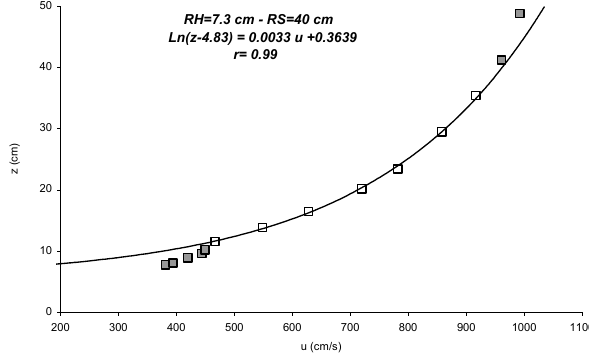
Fig. 2. Measured wind velocity profile (squares). Aerodynamic roughness length ( z 0 ) and the displacement height ( D ) are deter- mined by fitting on the log-law profile (Eq. 4, continuous line) only the wind velocity measurements corresponding to the white squares. ( RH , ridge height; RS , ridge